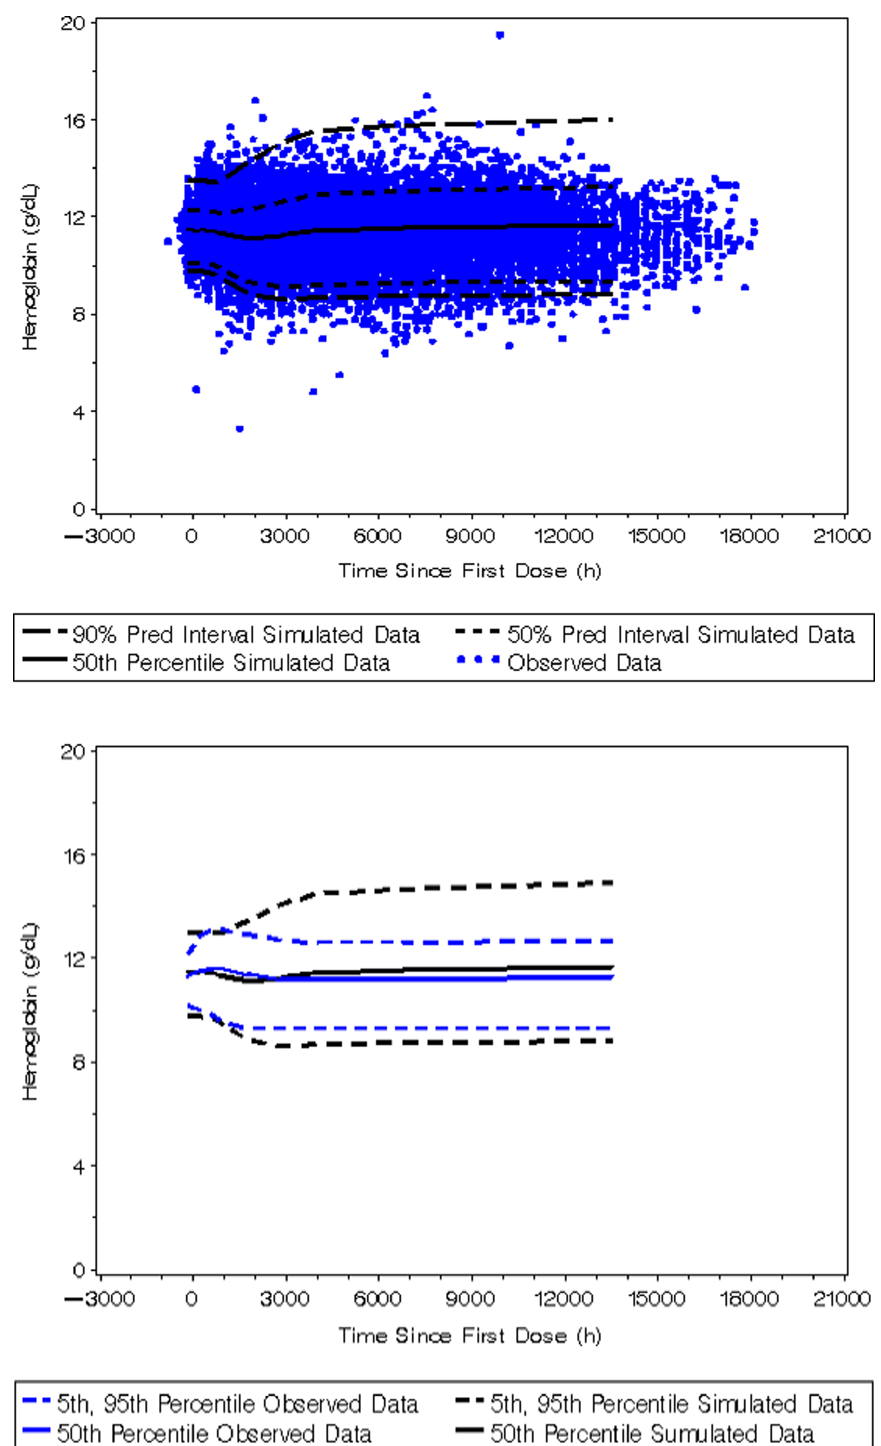
Figure 4. Visual predictive check for the PK-PD model of peginesatide using traditional visual predictive check.